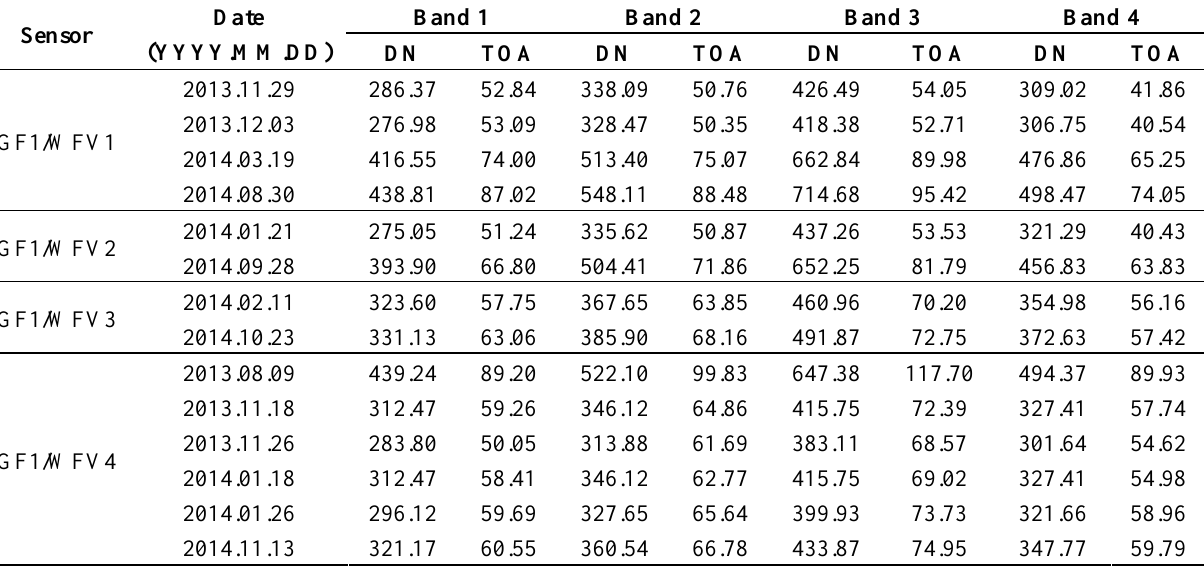
Table 10. Mean TOA radiance and DN for every GF-1/WFV